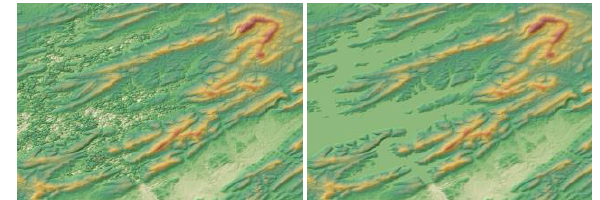
Figure 2. Left: WorldDEMcore (unedited); Right: WorldDEM (edited) Site: Lake Ouachita, Hot Springs, Arkansas, USA